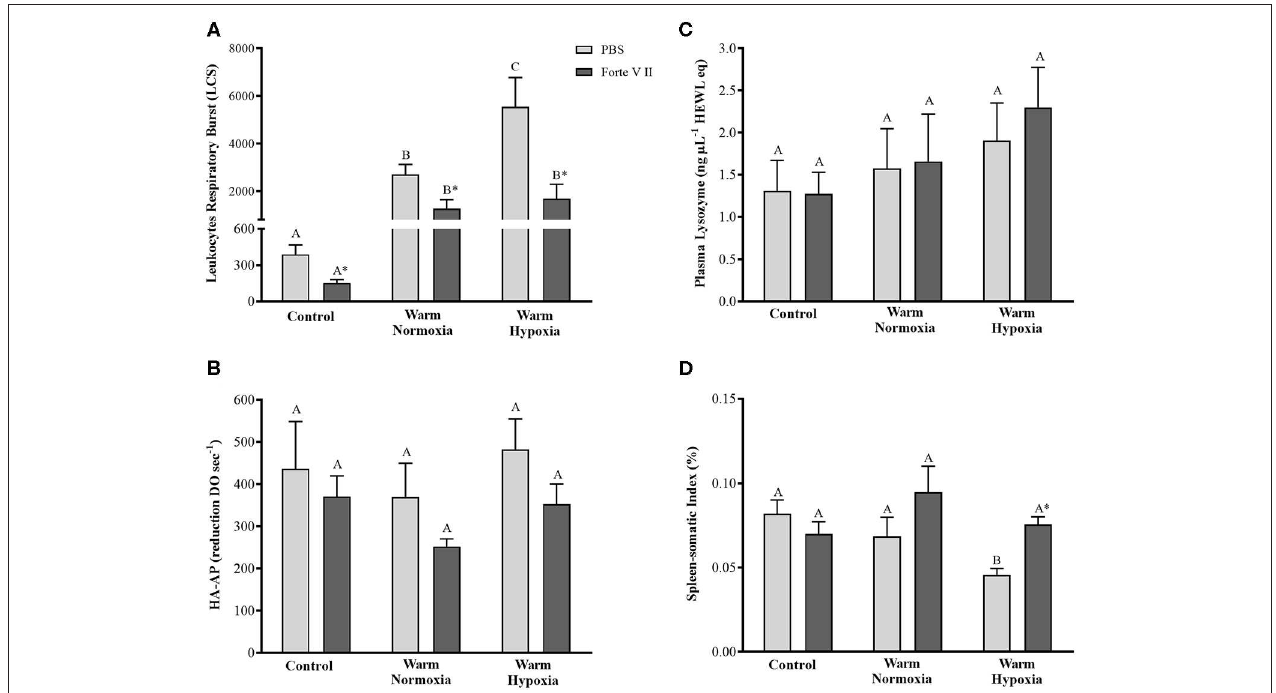
FIGURE 1 | Respiratory burst (A) , hemolytic activity of the complement system (B) , serum concentration of lysozyme (C) , and spleen-somatic index (D) in salmon held at 12 ◦ C (under normoxia) or 20 ◦ C (under normoxia or mild hypoxia) (i.e., treatment) 24h post-intraperitoneal injection with PBS or Forte V II (i.e., injection group). Different capital letters indicate a significant difference ( P < 0.05) among treatments for PBS or Forte V II-injected fish. An asterisk (*) indicates a significant difference between PBS and Forte V II injection groups within a treatment. Values are means ± 1 standard error (S.E.), N = 7–8.